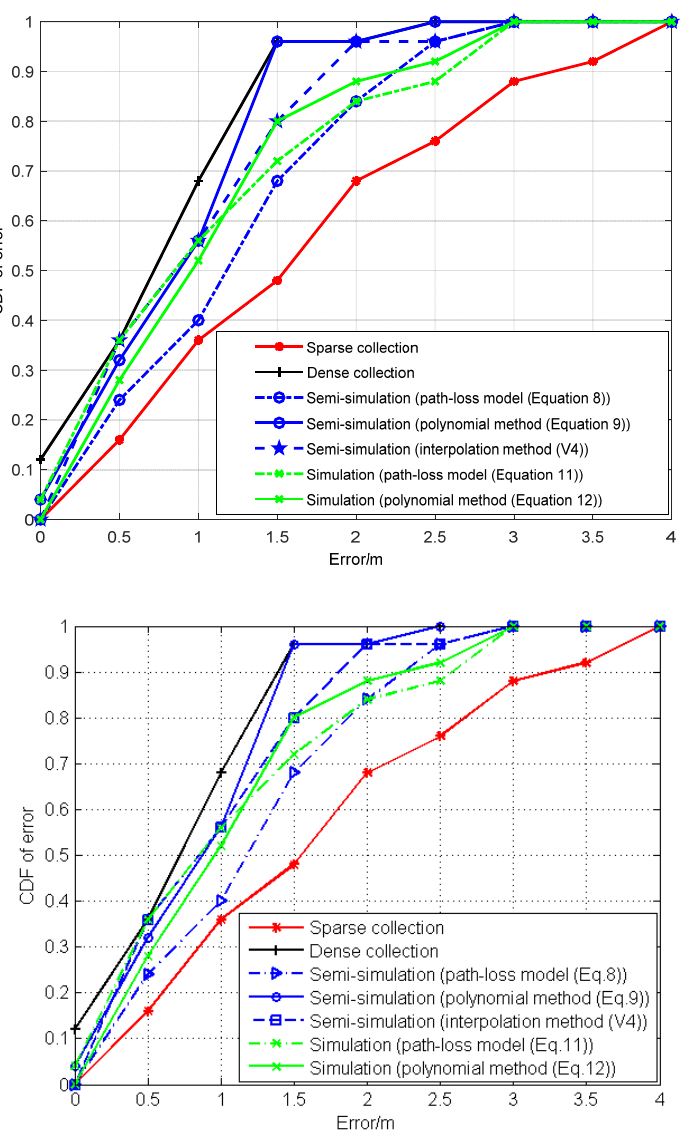
Figure 12. Cumulative distribution function of the positioning errors from different RSS fingerprint dataset construction methods (with 10 coarse site-surveying grids).